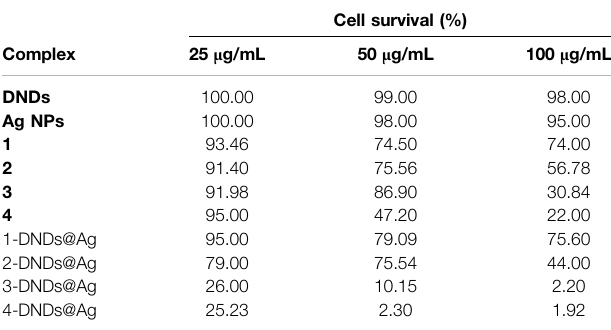
TABLE 3 | Cell survival values of samples in 1% DMSO/PBS after 30 min irradiation on S. aureus bio fi lms.